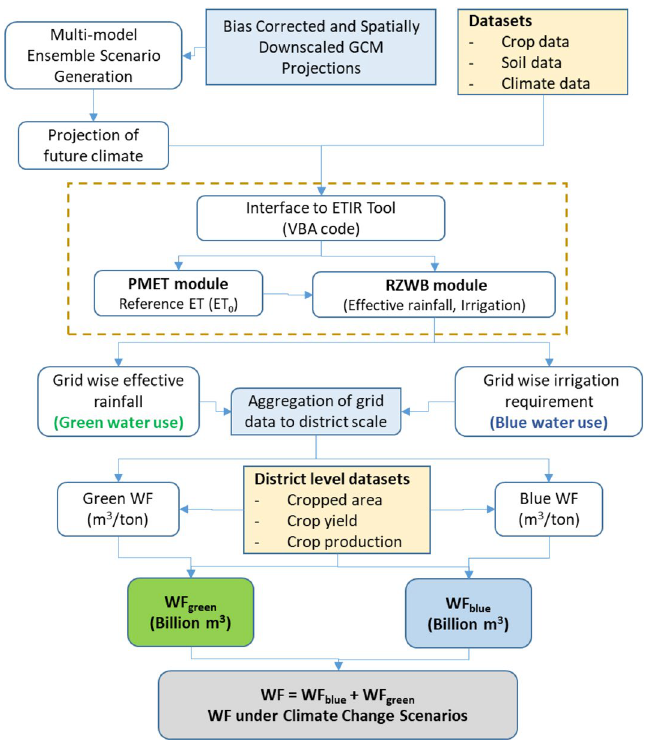
Figure 7. Methodological framework for the assessment of climate change impact on the WF.